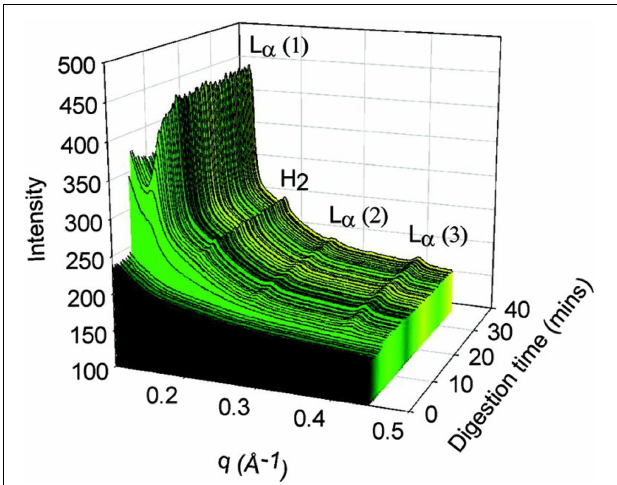
FIGURE 6 | The formation of liquid crystalline structures during the digestion of a self-nanoemulsifying drug delivery system (SNEDDS) by Warren et al. (2011). Scattering profiles of the digest are shown as a function of time (min), and the peaks that arise during digestion were attributed at the time to L α and H 2 phases although it is likely from more recent studies that the lamellar phase is due to calcium soap formation (Clulow et al., 2018). Adapted with permission from Warren et al. (2011). Copyright (2011) American Chemical